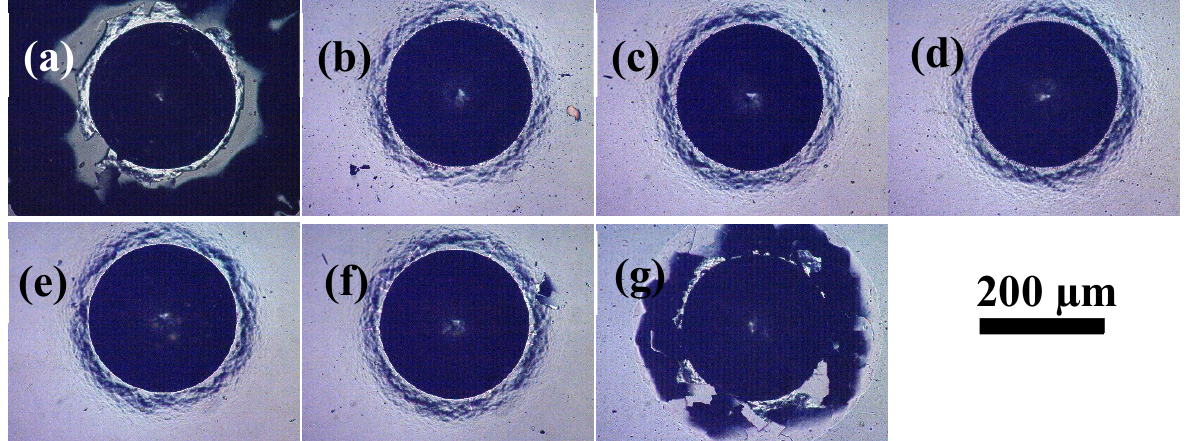
Figure 10. Indentation adhesion analysis of CrC/a-C:H coatings. The CrC interlayer was deposited with the C 2 H 2 flow rate of ( a ) 0, ( b ) 5, ( c ) 10, ( d ) 15, ( e ) 20, ( f ) 25, and ( g ) 30 sccm. The critical loads of scratch according to ISO 20,502 and the indentation adhesion class according to VDI standard 3189 of the CrC/a-C:H coating samples are listed in Table 2. Table 2. Adhesion classes and critical loads of the CrC and CrC/a-C films.